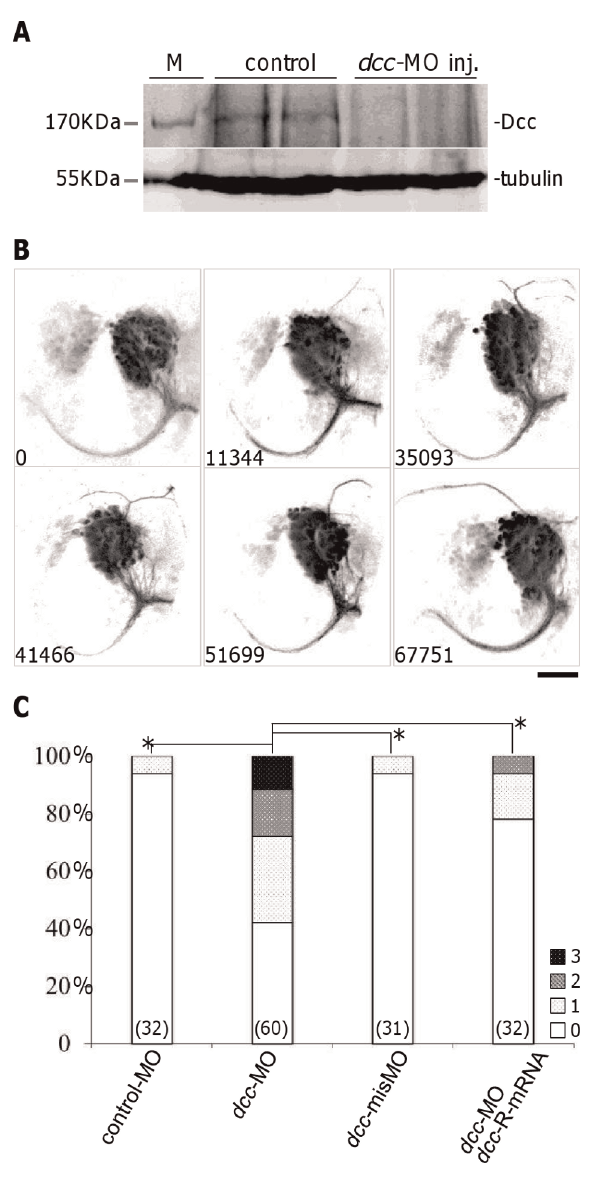
Figure 3. Dcc is required for correct asymmetric outgrowth of ADt neuronal axons. ( A ) Dcc expression was reduced after injection of dcc translation-blocking morpholinos into zebrafish embryos. Endogenous Dcc protein was detected as a band of approximately 170 kb. Tubulin served as a loading control. M: size marker. ( B ) ADt neurons project axons dorsally when Dcc function is inhibited by morpholino injection. Images of live animals were acquired as in Fig. 1C. The pixel intensity value of aberrant axon is shown in the bottom left corner of each panel. Scale bar=50 m m. ( C ) Quantitation of ADt neuronal axon defects. Horizontal axis shows the treatment group labels and vertical axis shows the percentage of embryos in each phenotypic category (Grade 0–3) for each treatment group. Numbers inside parentheses denote numbers of animals analyzed for each treatment group. Asterisks and brackets represent p , 0.05 by Mann- Whitney U test.